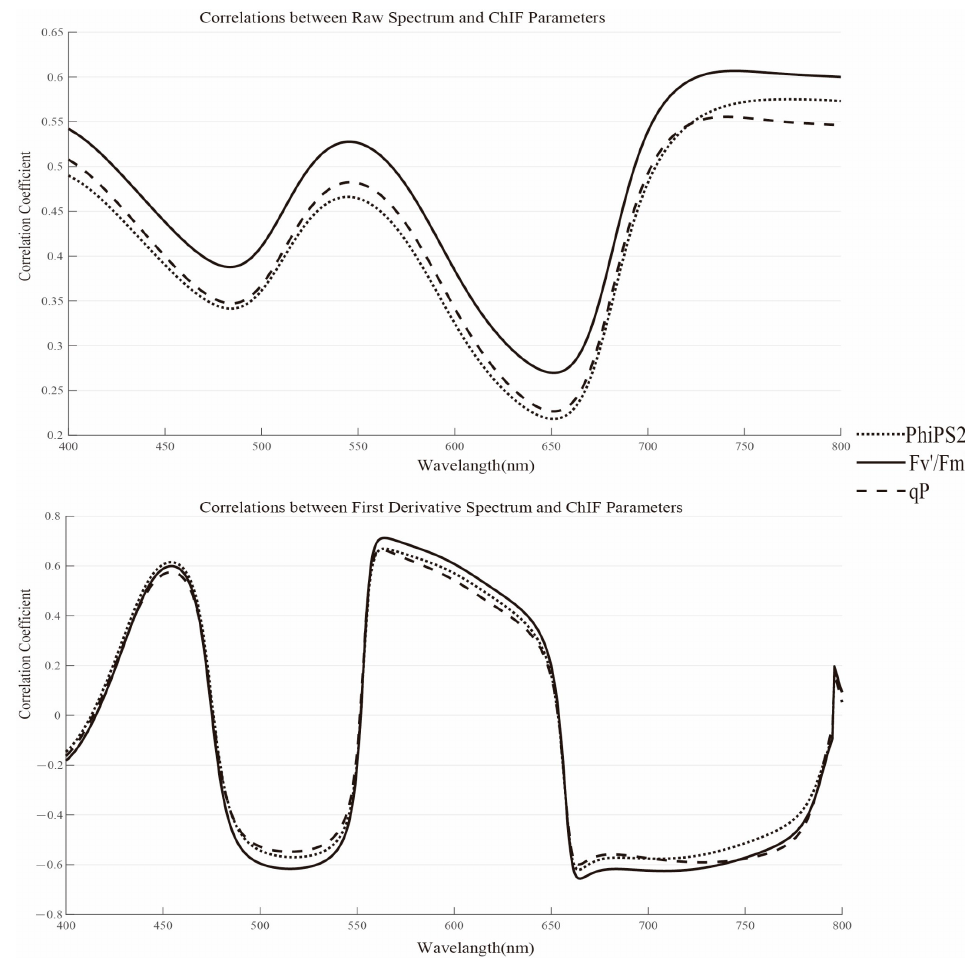
Figure 4. Correlation coefficients between PhiPS2, Fv'/Fm' , qP, and the raw canopy and first-derivative spectral data.